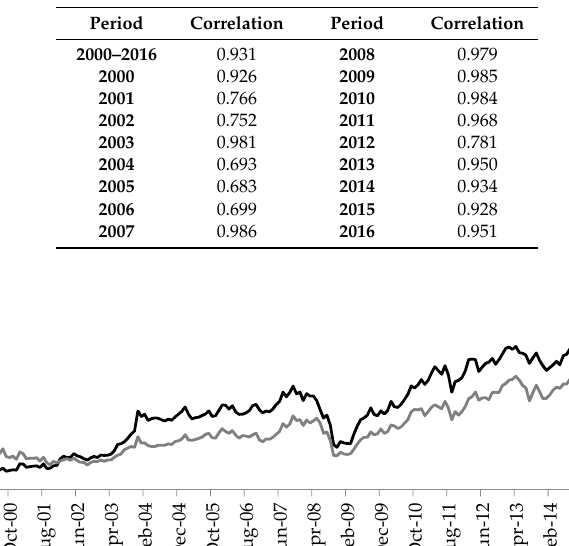
Table 2. Correlation between value and growth index.